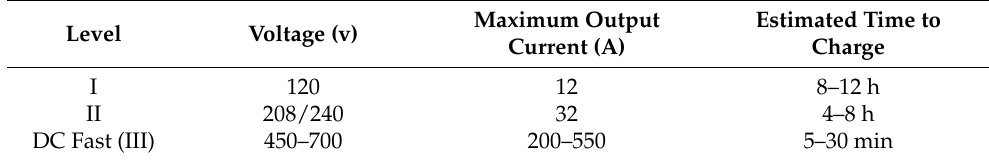
Table 8. Types of Charging Stations’